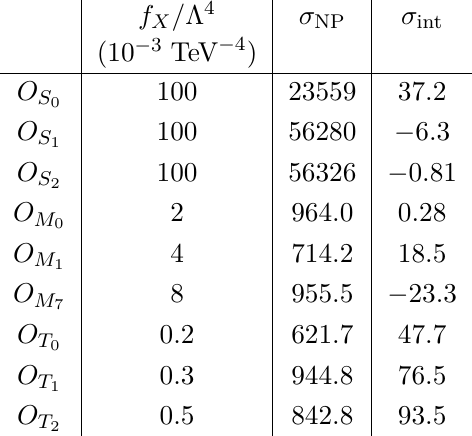
Table 6 . Cross-sections (ab) of interference terms and squared